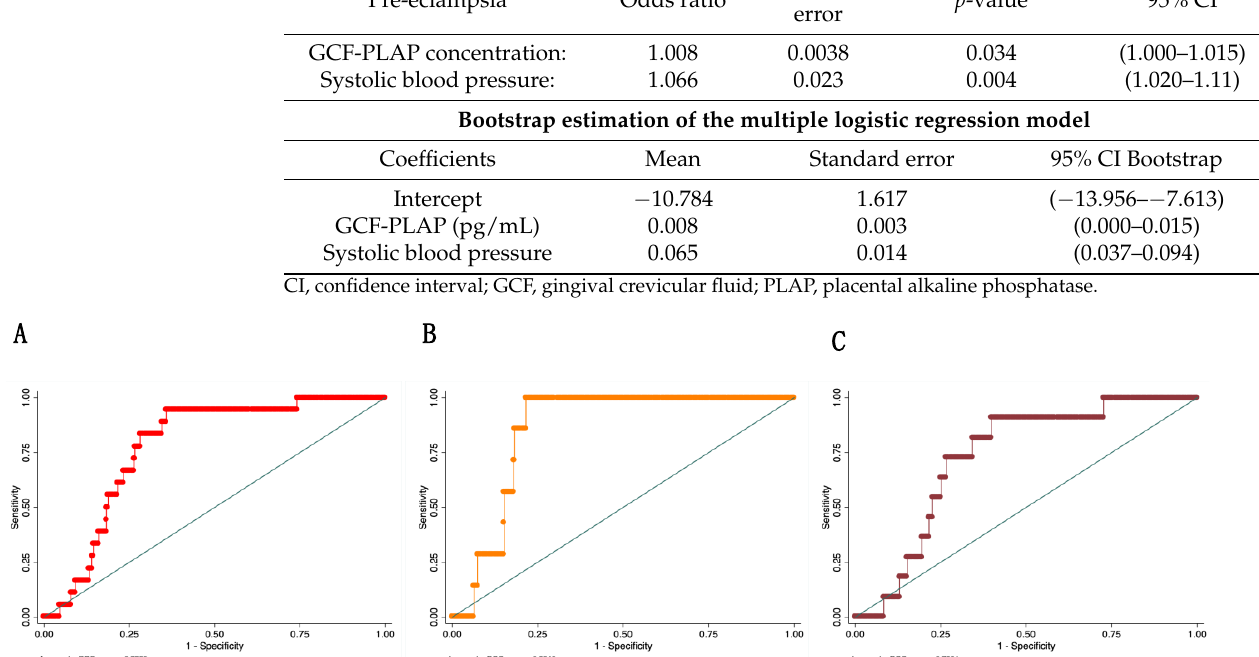
Figure 2. ( A ) Placental alkaline phosphatase (PLAP) concentrations (pg/mL) in gingival crevicular fluid (GCF) in pregnancy according to the presence or absence of pre-eclampsia. ( B ) Plasma and GCF-PLAP concentrations at 11–14 weeks of gestation in women with and without pre-eclampsia. GCF, gingival crevicular fluid; PLAP, placental alkaline phosphatase. Table 2. Association between GCF-PLAP concentration and systolic blood pressure at 11–14 weeks of gestation, according to the presence or absence of pre-eclampsia: multiple regression logistic models (A) and bootstrap estimation of the multiple logistic regression model (B).